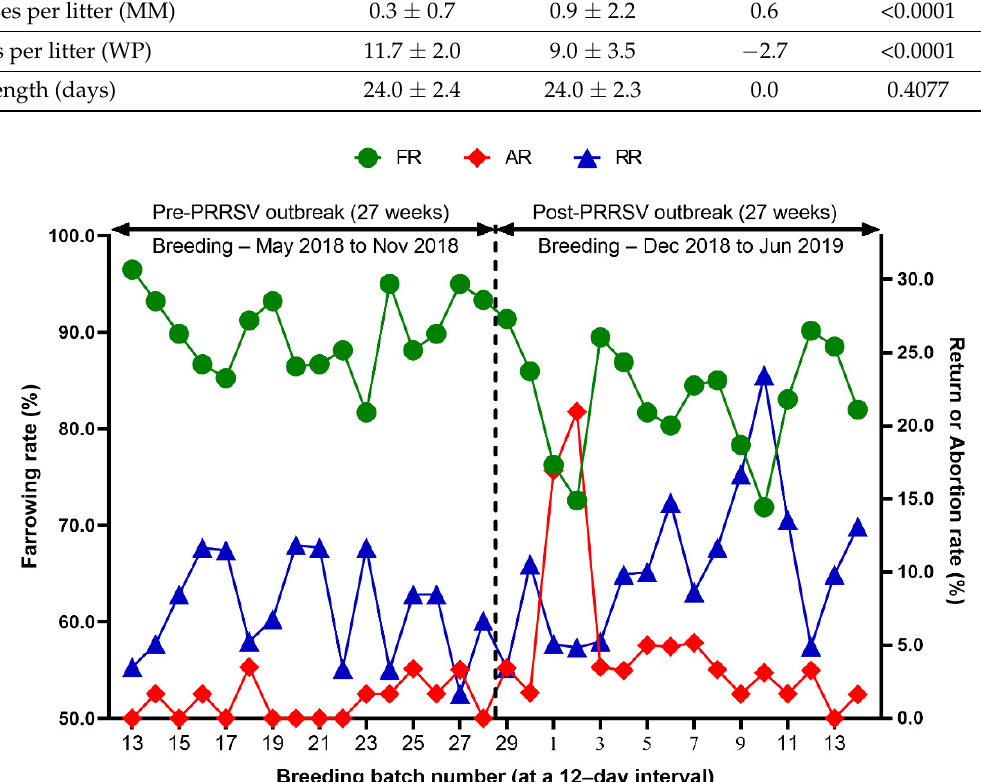
Figure 3. Comparison of the farrowing rate (FR), the abortion rate (AR), and the return rate (RR) before and after a PRRS outbreak.